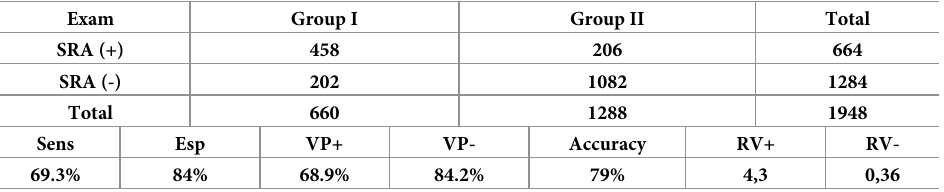
Table 2. Detection of FAPO risk in Groups I and II by the SRA. The numbers correspond to the total of positive and negative stretches in each